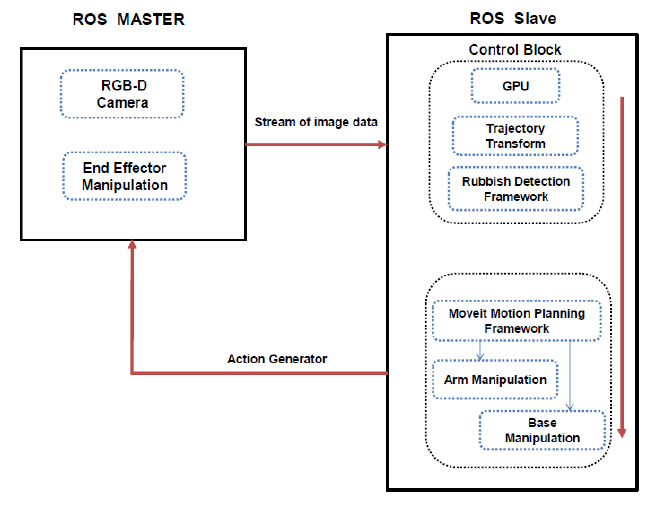
Figure 5. Human Support Robot (HSR) hardware architecture